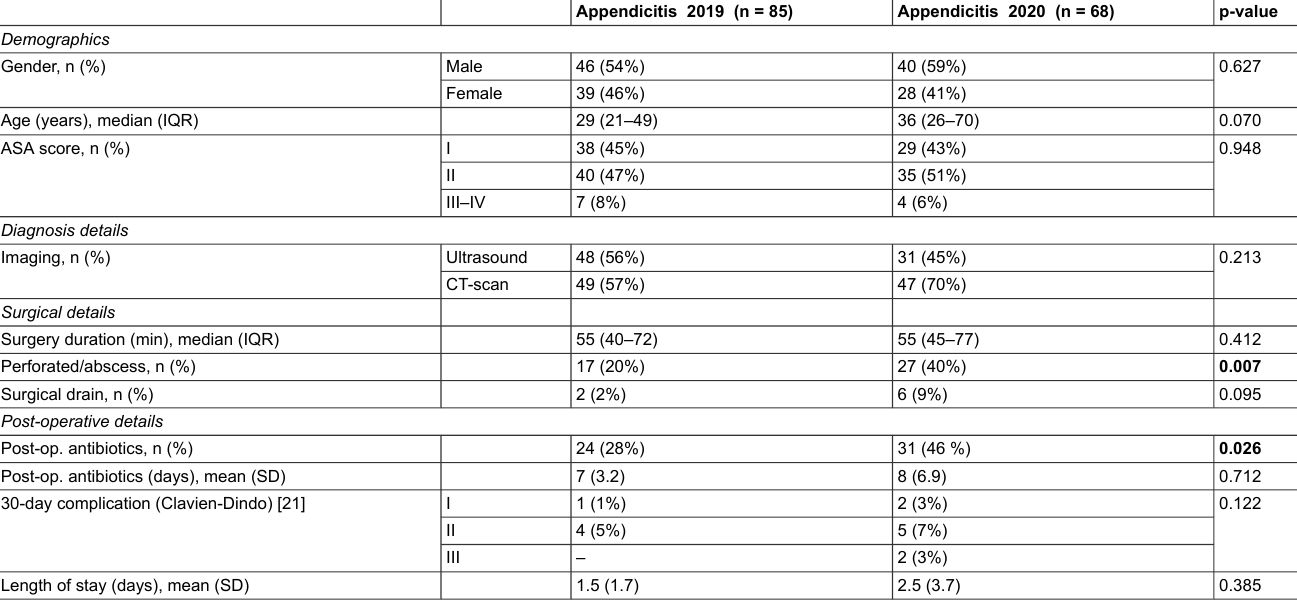
Table 1: Baseline demographics, diagnosis, surgical and post-operative details for appendicitis: comparison between 2020 and 2019.